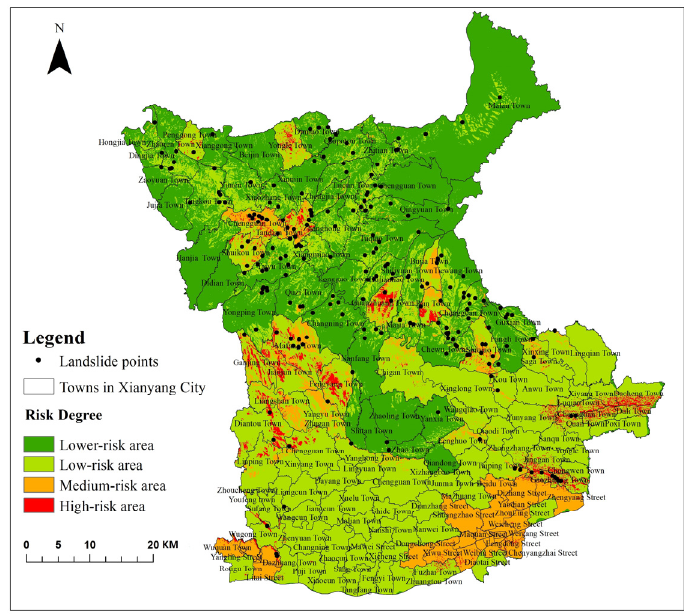
Figure 12. Landslide risk values in Xianyang City.